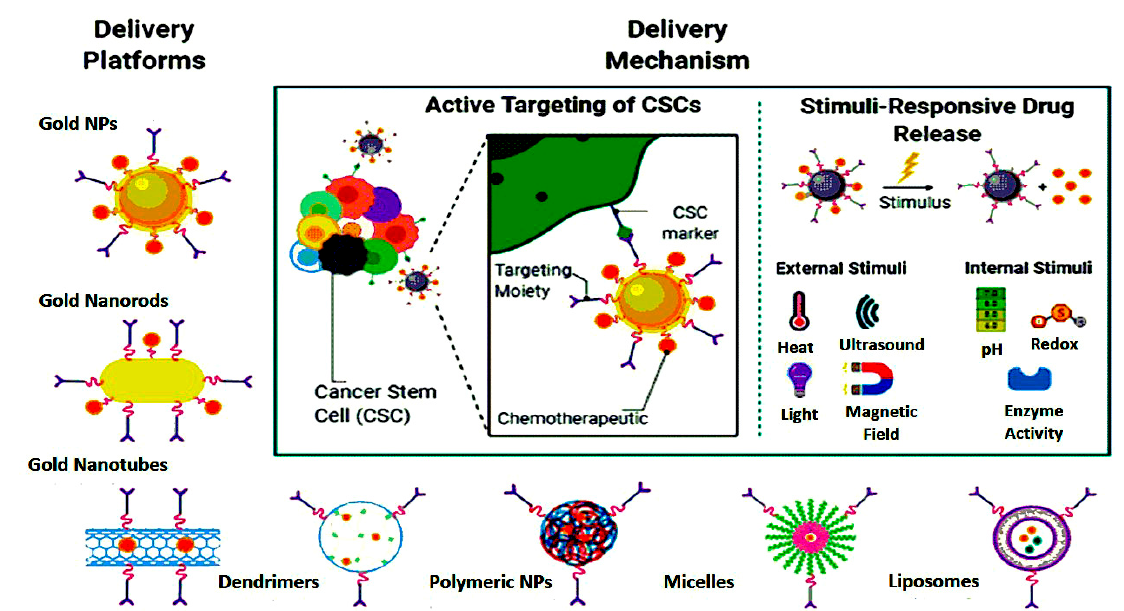
Figure 4. Nanoparticle-mediated targeted drug delivery to cancer stem cells (CSCs), created in Biorender.com. The cancer stem cells (CSCs) express the surface markers that can serve as therapeutic targets for the elimination of CSCs. Different nanocarriers can be used for OSA therapy and can be decorated with surface ligands, specific to the CSCs markers and can release the embedded moiety by the stimuli. Figure 5 shows ligand anchored nanocarrier and its interaction with OSA.